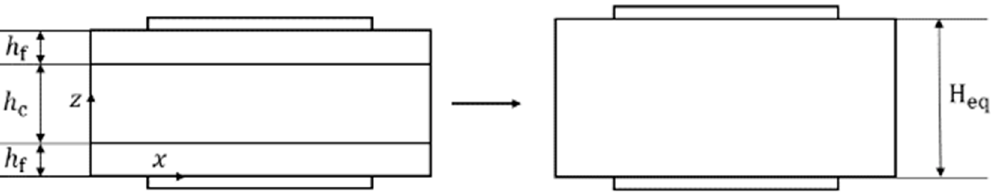
Figure 3. Equivalent schematic of a honeycomb core sandwich plate.